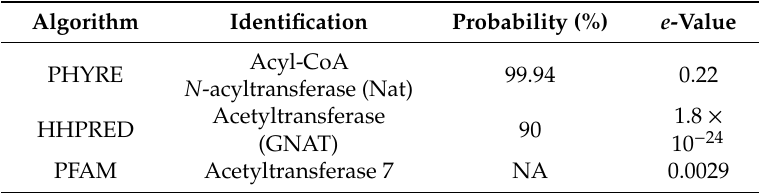
Table A2. Result of the in silico analysis of the primary Rac sequence using various